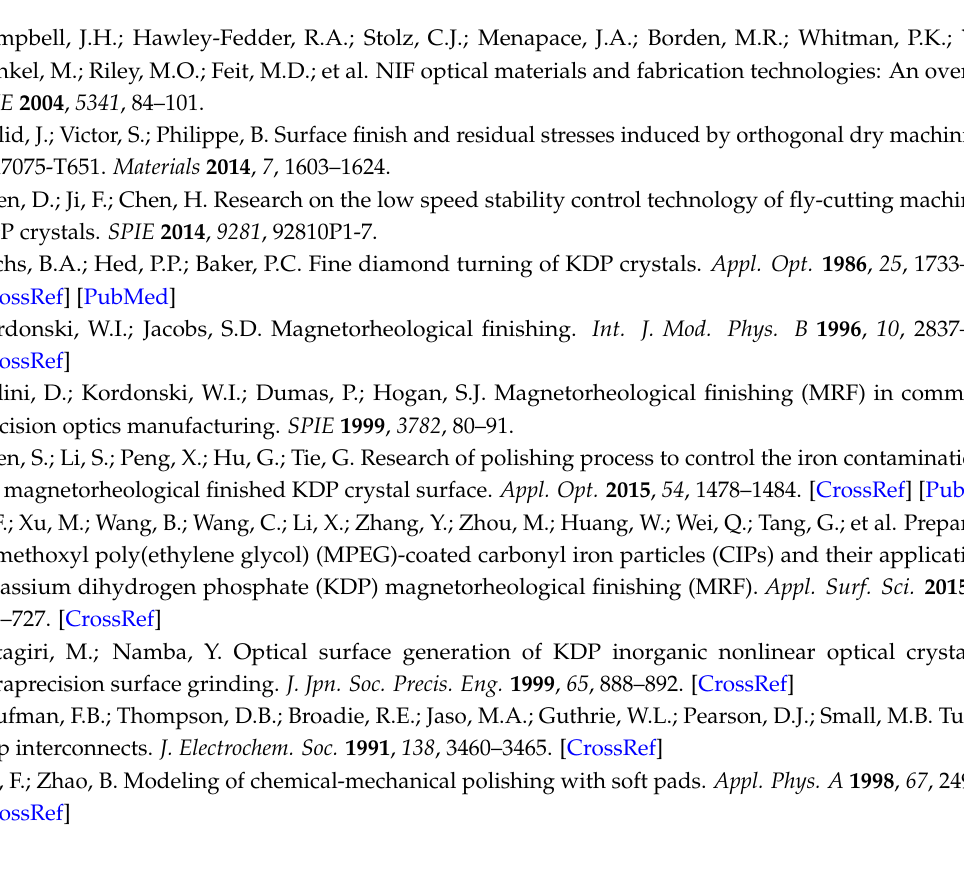
Figure S1: Outline of crossing section for different KDP samples: (a) KDP after SPDT; (b) KDP after CMP with traditional W/O microemulsion; and (c) KDP after CMP with functional KDP aq/O microemulsion ( c KDP was 30